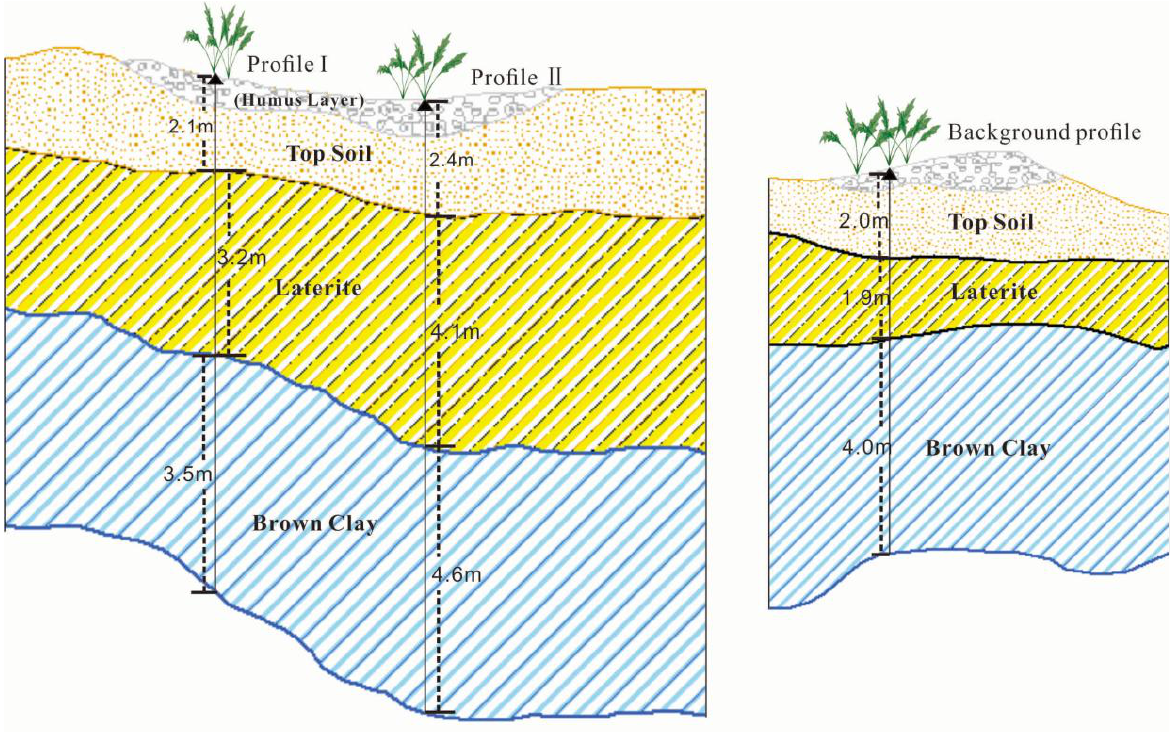
Figure 3. The stratified soil layers of sampling profiles.